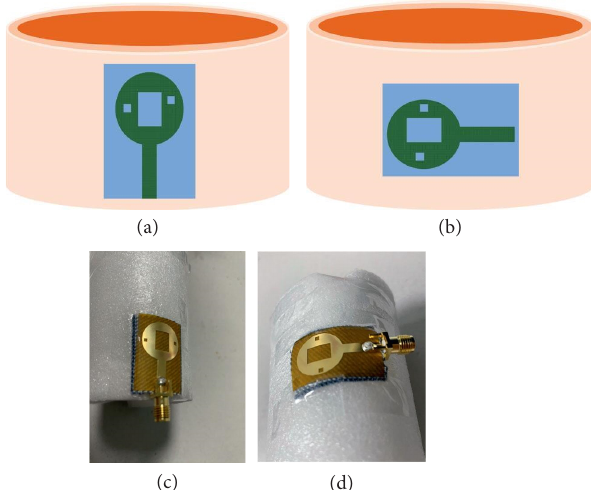
Figure 7: Structural deformation. (a) Simulated X -bend. (b) Simulated Y -bend. (c) Measured X -bend. (d) Measured Y